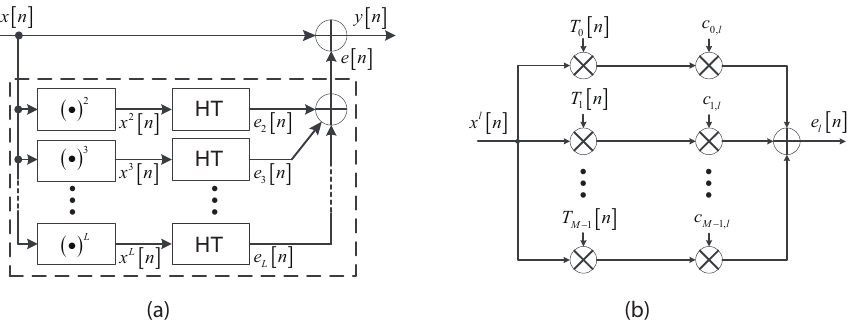
Figure 3. ( a ) Model of M -TIADC with nonlinear mismatches; ( b ) the detail of the Hadamard transform (HT)